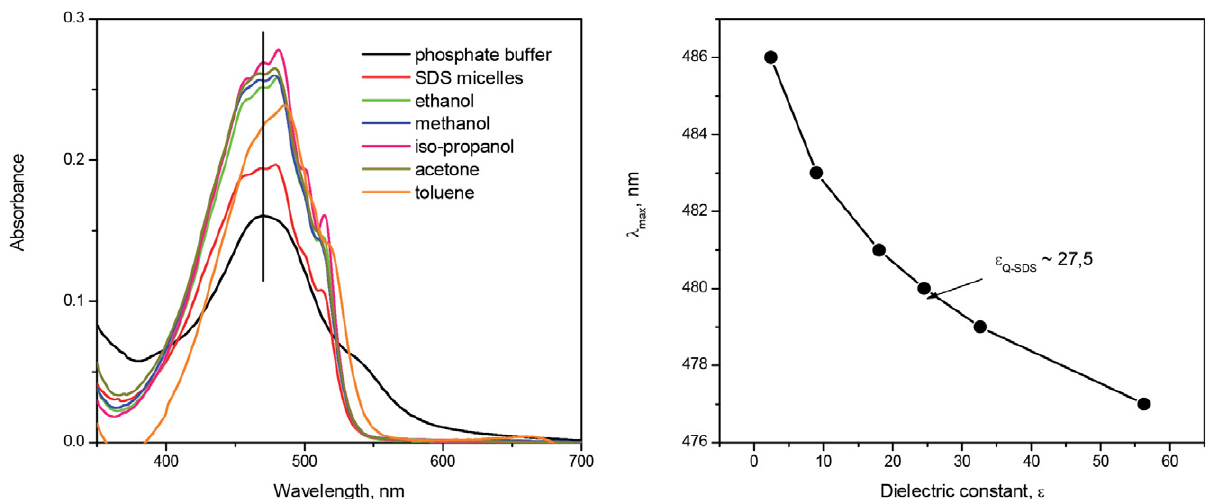
Figure 9. (a) Absorption spectra of quinizarin in different solvents and SDS micelles; (b) Absorption maxima of quinizarin in different solvents as a function of the dielectric